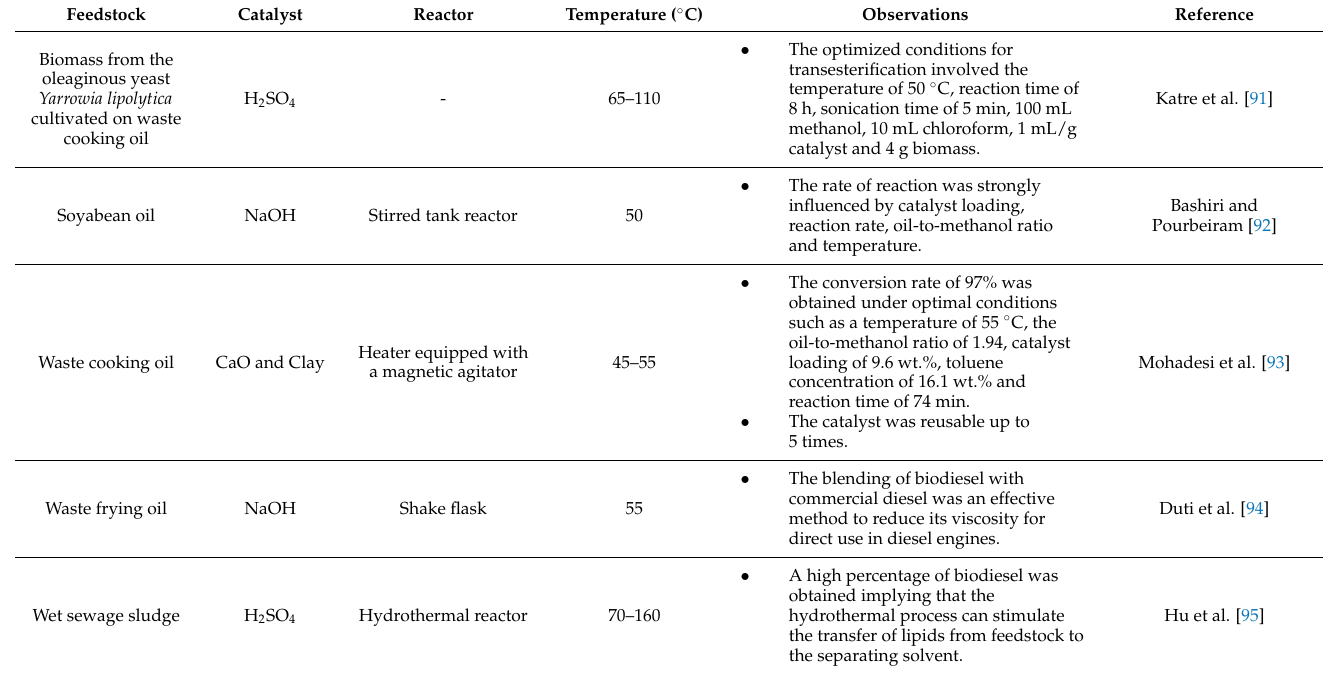
Table 6. Summary of notable works on transesterification of waste oil and biomass to